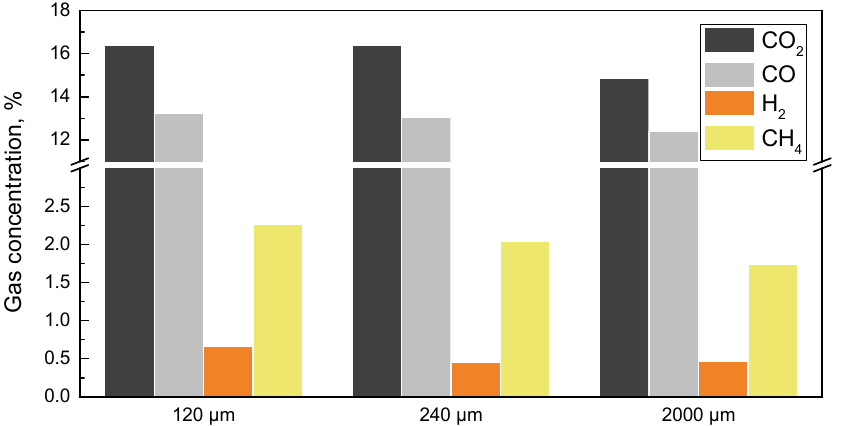
Figure 3. Gas component concentrations in the pyrolysis of biomass (sawdust 25%, straw 50%, leaves 25%) with different particle sizes at a pyrolysis temperature of 500 °C.